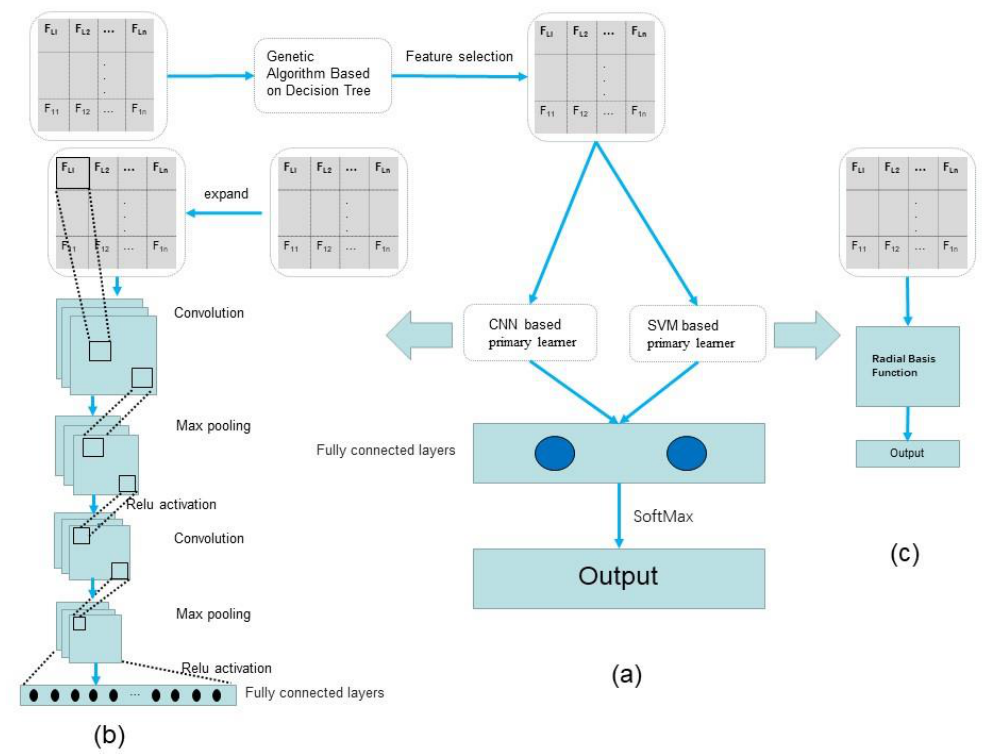
Figure 2. Network structure of GA-stacking. ( a ) shows the structure of GA-Stacking. ( b ) shows the structure of simplified CNN. ( c ) shows the structure of SVM.